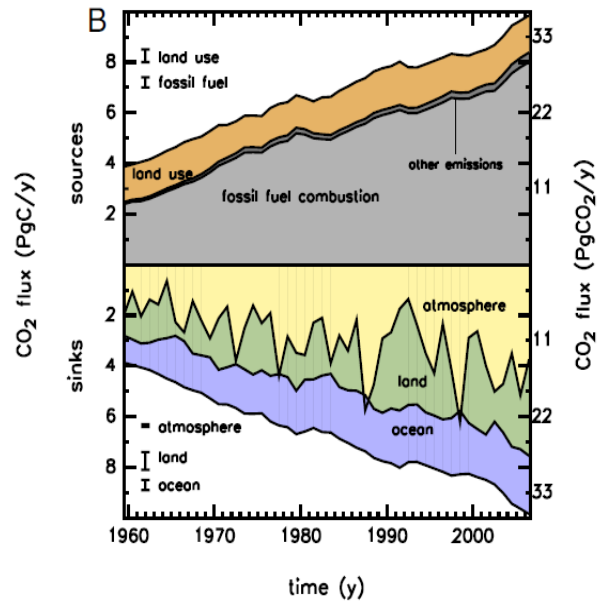
budget from 1959 to 2006. Upper panel: CO Figure 2. Global CO 2 atmosphere (sources) as the sum of fossil fuel combustion, land-use change, and other emissions. Lower panel: The fate of the emitted CO CO plus the sinks of CO on land and in the ocean 2 2